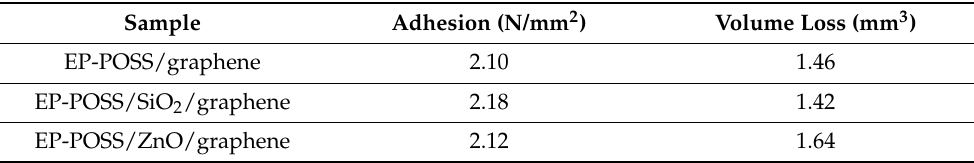
Table 2. Adhesion and wear resistance test of EP-POSS nanocomposite.